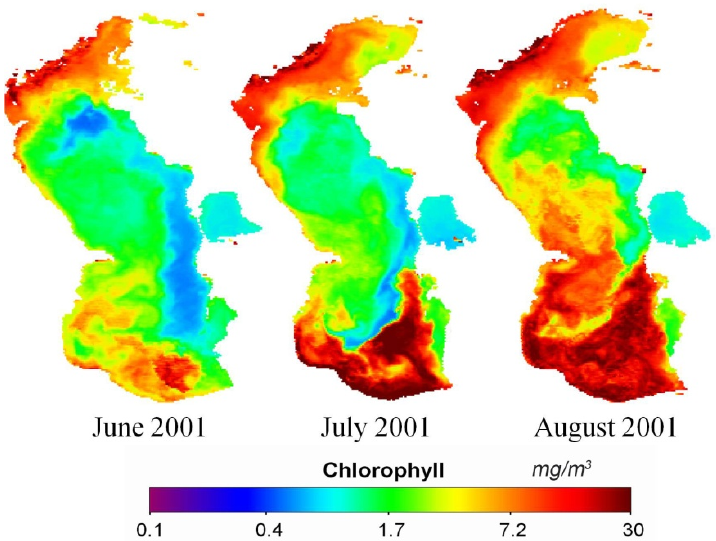
Figure 7. Chlorophyll distribution in the Caspian Sea in June, July and August 2001 according to Modis-Aqua. to